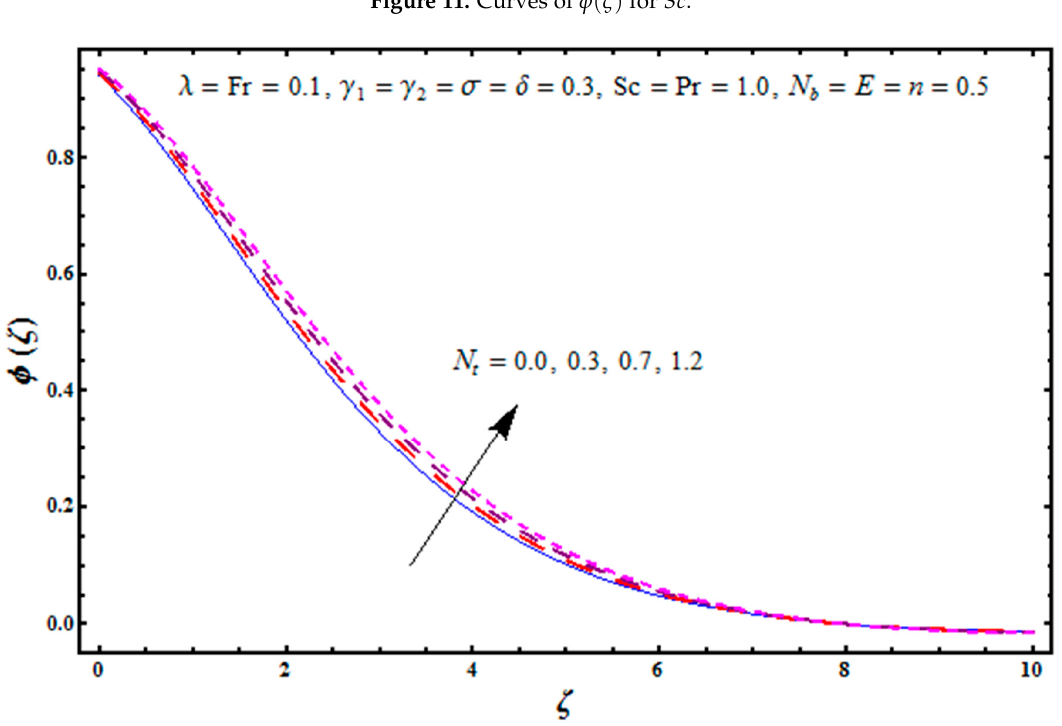
Figure 11. Curves of φ ( ζ ) for Sc .